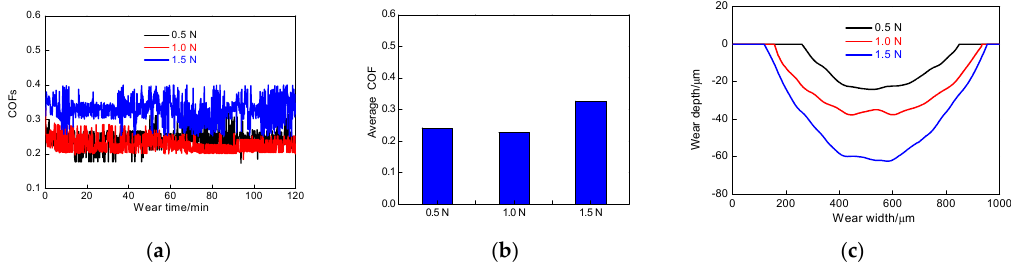
Figure 4. COFs vs. wear time and wear profiles of cold sprayed Al coatings after LR. ( a ) COFs vs. wear time; ( b ) Average COFs; ( c ) Wear profiles.